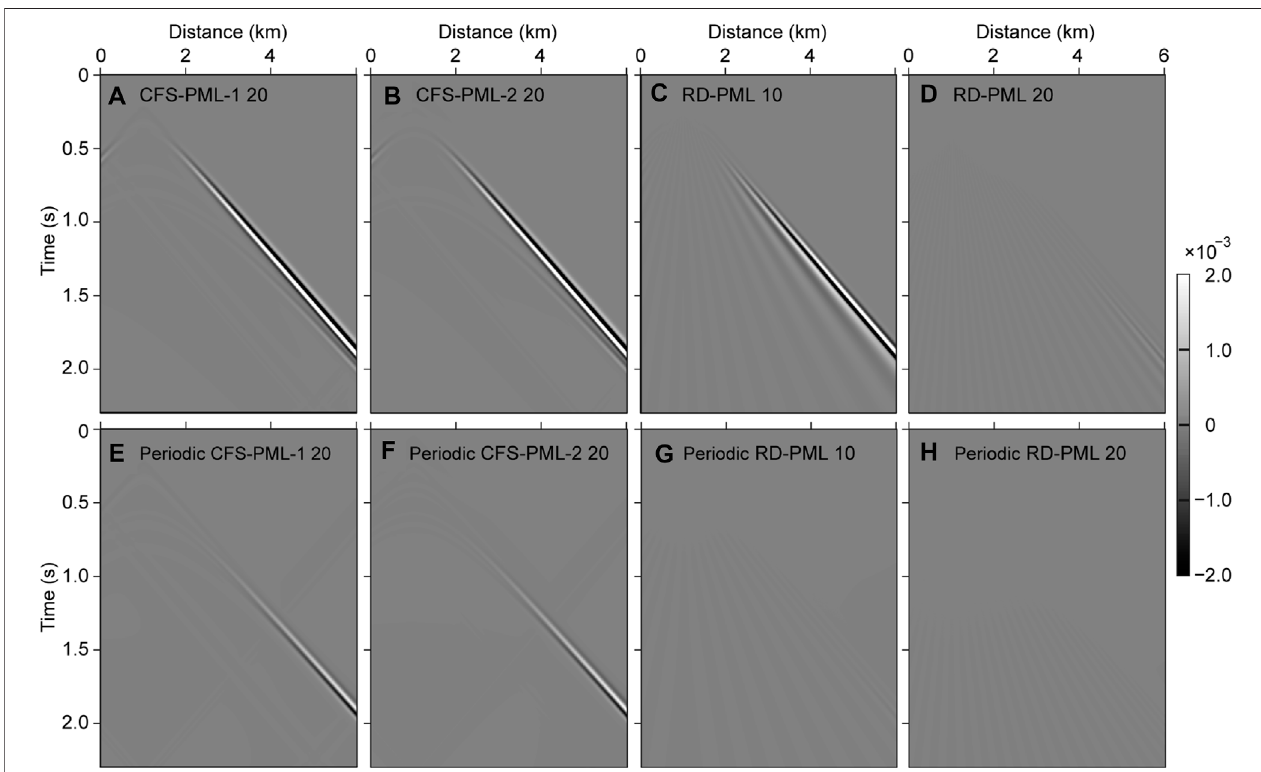
FIGURE8| Wave fi elddifferencebetweentheshotrecordsofdifferenttypesofPMLwiththetheoreticalshotrecordsthatshownin Figure7B . (A) , (B) , (C) ,and (D) are the wave fi eld difference between the shot records of 20-layer CFS-PML-1, 20-layer CFS-PML-2, 10-layer RD-PML, and 20-layer RD-PML with the theoretical records,respectively. (E) , (F) , (G) ,and (H) arethewave fi elddifferencethattheshotrecordsusingperiodicboundariesforthecorrespondingtypesofPMLin (A) , (B) , (C) , and (D) , respectively.